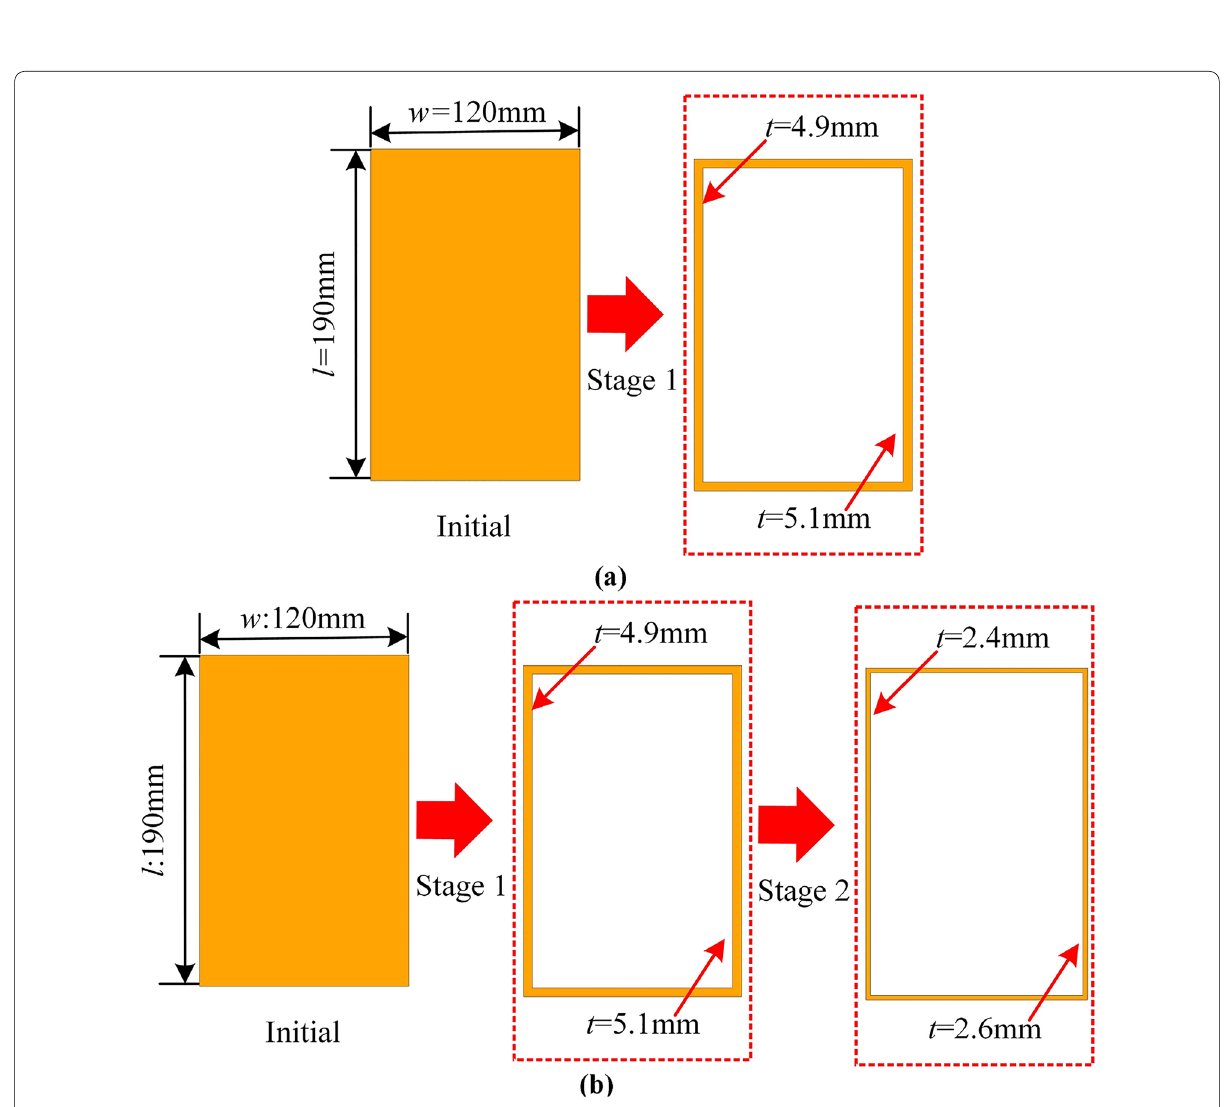
Figure 12 Machining process of: ( a ) Benchmark_1, ( b )